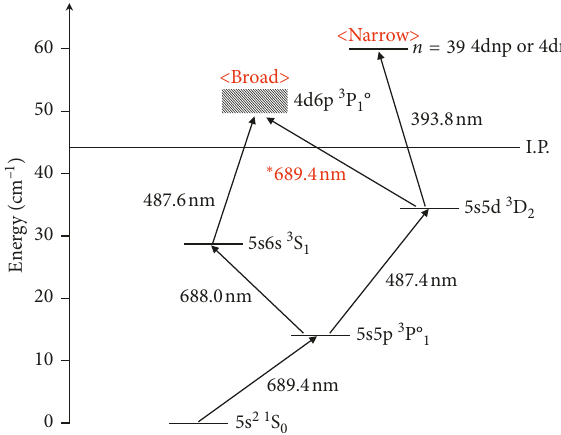
Figure 1: Excitation transition schemes described in the present study. The left-side transition (689.4 nm-688nm-487.6nm) is quoted from Reference